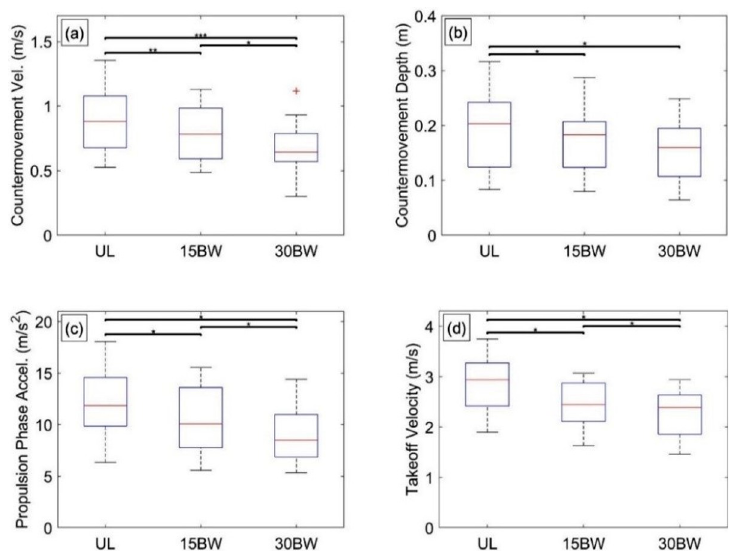
Fig 4. Vertical jump statistical results. Boxplots depicting the results from the Tukey post hoc analysis of vertical jump metrics for a) jump countermovement velocity, b) jump countermovement depth, c) jump propulsion phase acceleration, and d) jump takeoff velocity. The bars denote significant differences between loading conditions at a significance level α = 0.05 � , 0.01 �� , 0.001 ��� .